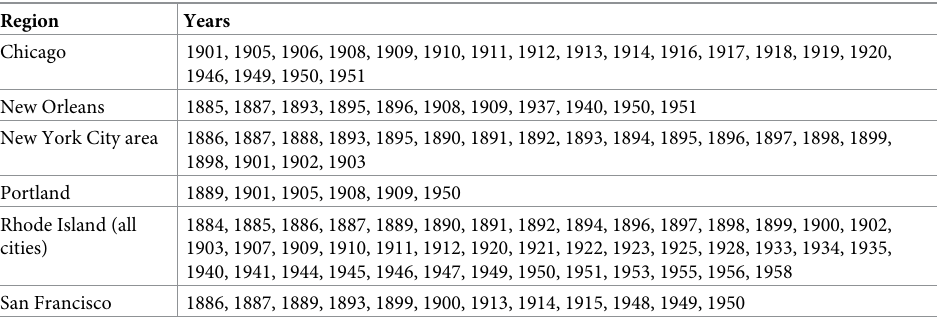
Table 1. Map volumes from sampled cities and